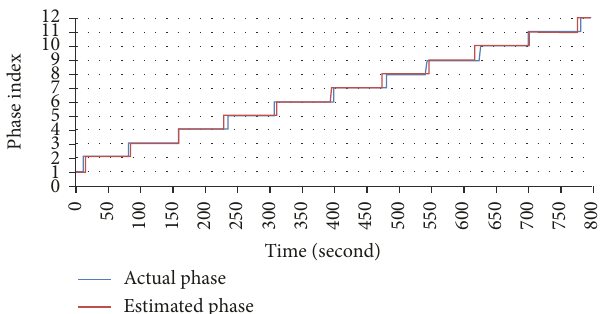
Figure 16: An example of phase segmentation outputs for a test surgical workflow using FrameDiff GridBlock Kmeans method.